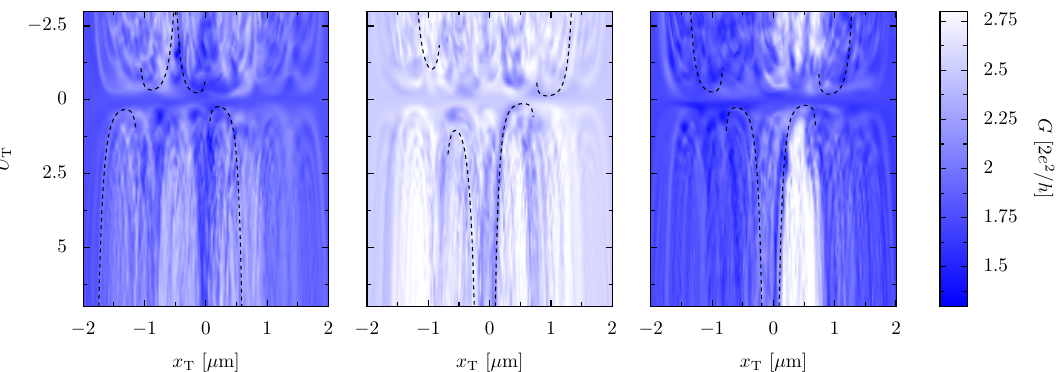
Figure 11: Quantum conductance through three samples with different disorder realizations. The consistence with our deflection mechanism of Sec. 4 is shown by the lines that represent constant deflection angle features according to Eq. (9). The parameters ( x , α ) are { ( − 1.1,0.0083 ) , ( 0.03, − 0.0059 ) } , { ( 0.74,0.0033 ) , B ( − 0.75, − 0.026 ) } , and { ( 0.715,0.0047 ) , ( − 0.8, − 0.0066 ) } for the left, central, and right panel,